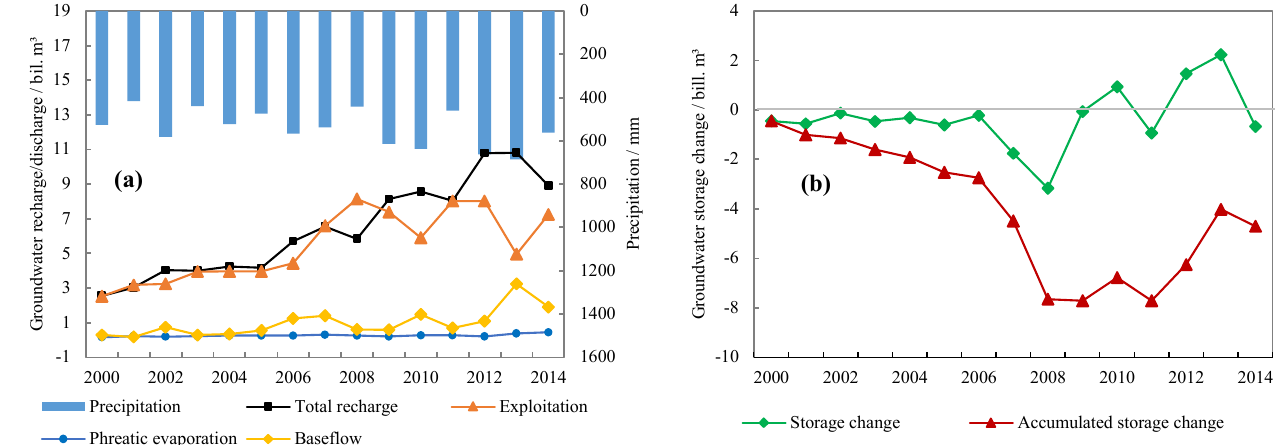
Figure 5. Dynamic change in groundwater under dynamic land-use mode. ( a ) Groundwater fluxes and precipitation; ( b ) groundwater storage change.